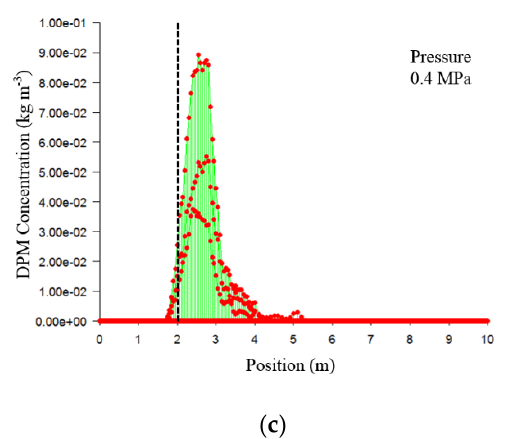
Figure 7. Concentration of droplets deposition under different pressures, ( a ) 0.2 MPa, ( b ) 0.3 MPa, and ( c ) 0.4 MPa. X-axis indicates different position of target area and off-target area, Y-axis shows DPM Concentration (kg m − 3 ) of droplets deposition under different pressure, 0.2 MPa, 0.3 MPa, and 0.4 MPa. The point means concentration of different position, the dotted line means the droplet concentration deposition center, and the solid line means the biggest concentration of corresponding point.